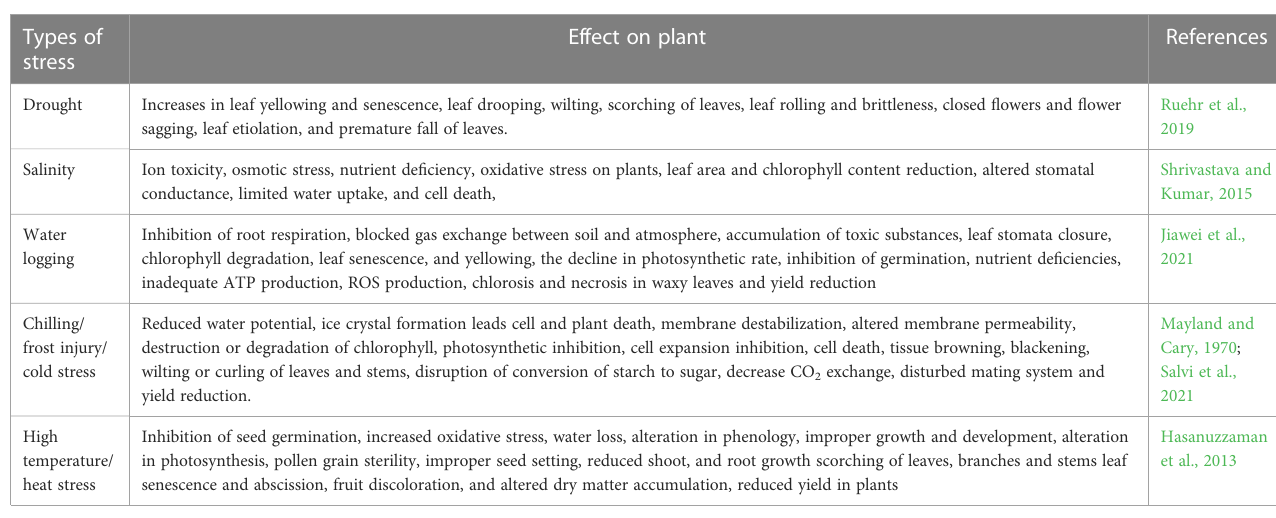
TABLE 1 Common responses of plants under abiotic stress